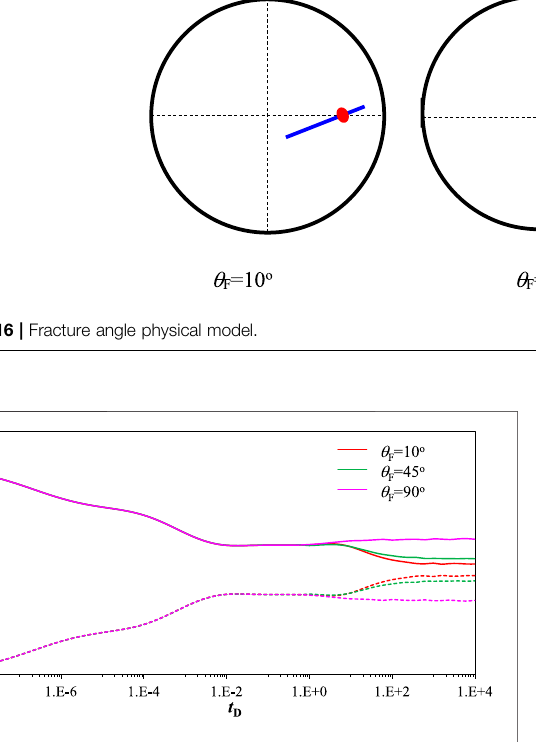
FIGURE 17 | Rate distribution curve affected by fracture angle. FIGURE 18 | Log-log fi tting